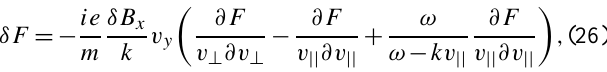
associated with various astrophysical phenomena, e.g., pul- sar winds (Kazimura et al., 1998), gamma-ray bursts, and/or their afterglows (Medvedev and Loeb, 1999) or gravitational collapse of large-scale structures in the universe (Schlick- eiser and Shukla, 2003). The Weibel instability generates magnetic fields on a very small spatial scale of the order of plasma skin depth. In contrast to MI the Weibel instability is driven by the electrons with anisotropic velocity